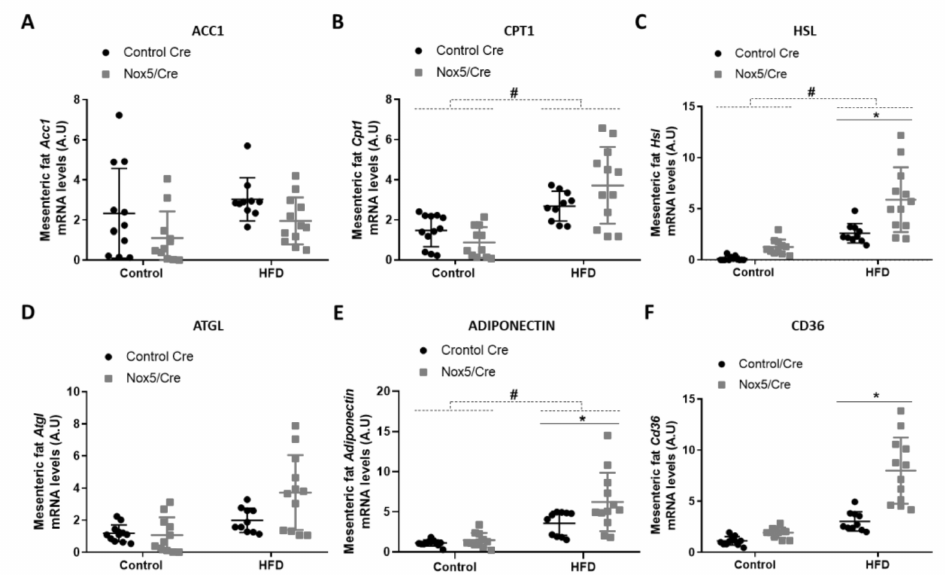
Figure 2. Endothelial NOX5 expression increased Hsl , Adiponectin and Cd36 mRNA expression levels in mesenteric fat in mice fed a HFD for 10 weeks. ( A ) Acc1 mRNA levels. ( B ) Cpt1 mRNA levels. ( C ) Hsl mRNA levels. ( D ) Atgl mRNA levels. ( E ) Adiponectin mRNA levels. ( F ) Cd36 mRNA levels. Control diet: control Cre ( n = 12), Nox5/Cre ( n = 11); HFD: control Cre ( n = 10), Nox5/Cre ( n = 12). Results are expressed as mean ± SEM. mRNA levels are relative to Gapdh . # p < 0.05: diet differences (dotted lines); * p < 0.05: genotype differences (solid lines). Statistical test used: two-way ANOVA.